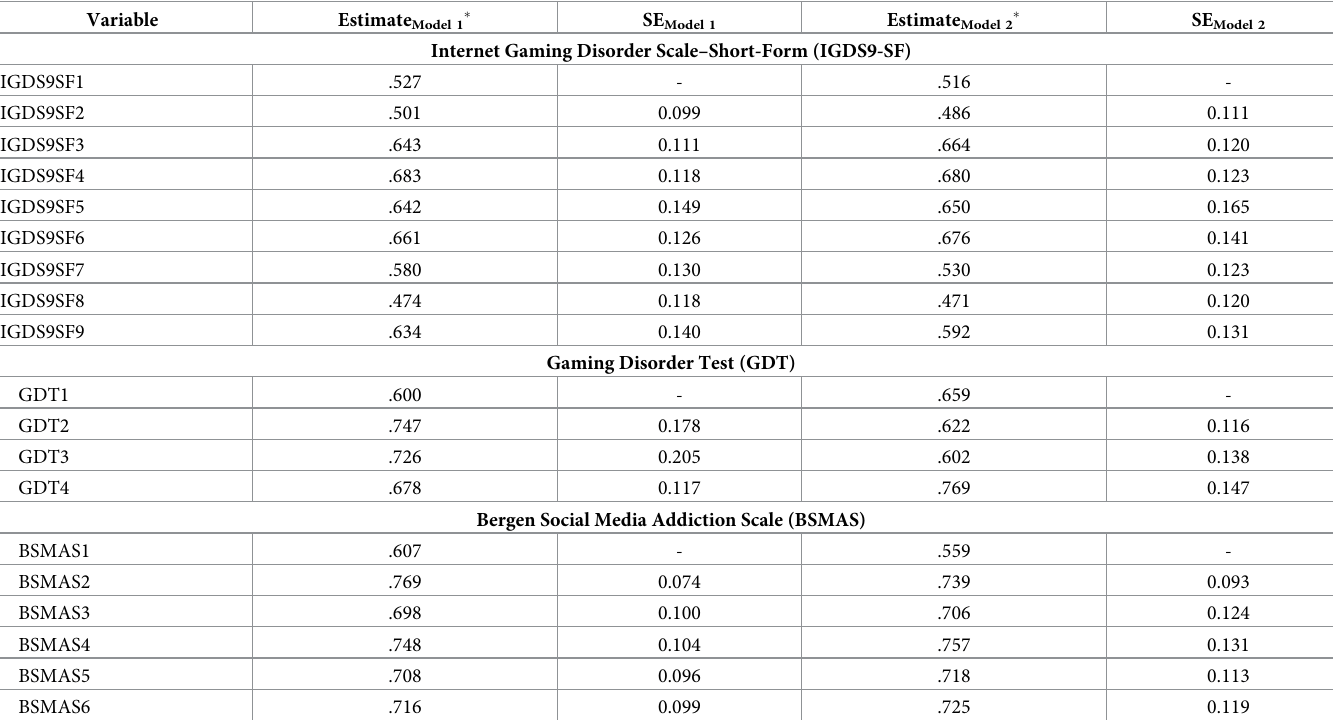
Table 5. Summary of the Confirmatory Factor Analysis results ( N =